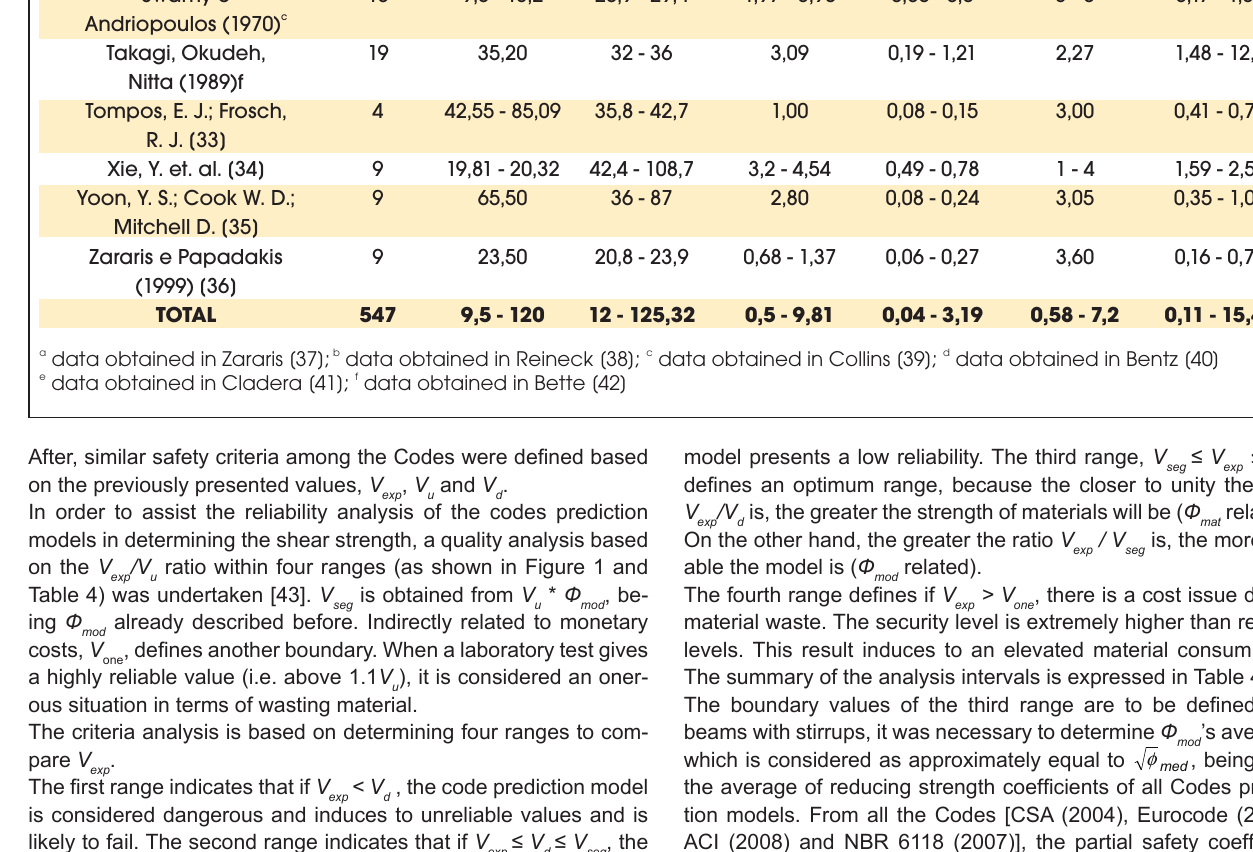
Table 3 – Equations Determination of design shear resistance, using the division by g Determination of design shear resistance, using multiplication by Φ Determination of ultimate safety factor, Φ Coefficients of ultimate safety factor, Φ , being Φ mat: partial safety coefficient provided by the variability and the possibility of a low material strength and Φ mod: safety coefficient provided by the inaccuracy of the model